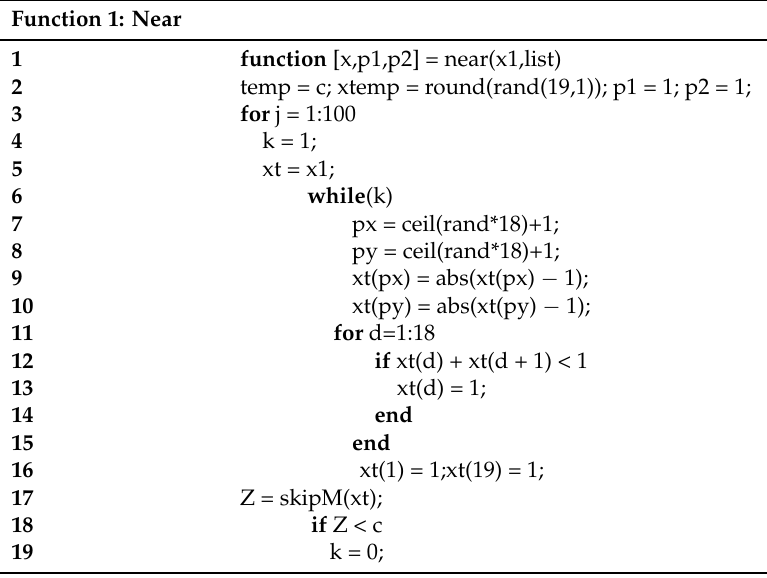
Table A2. Neighborhood search of tabu